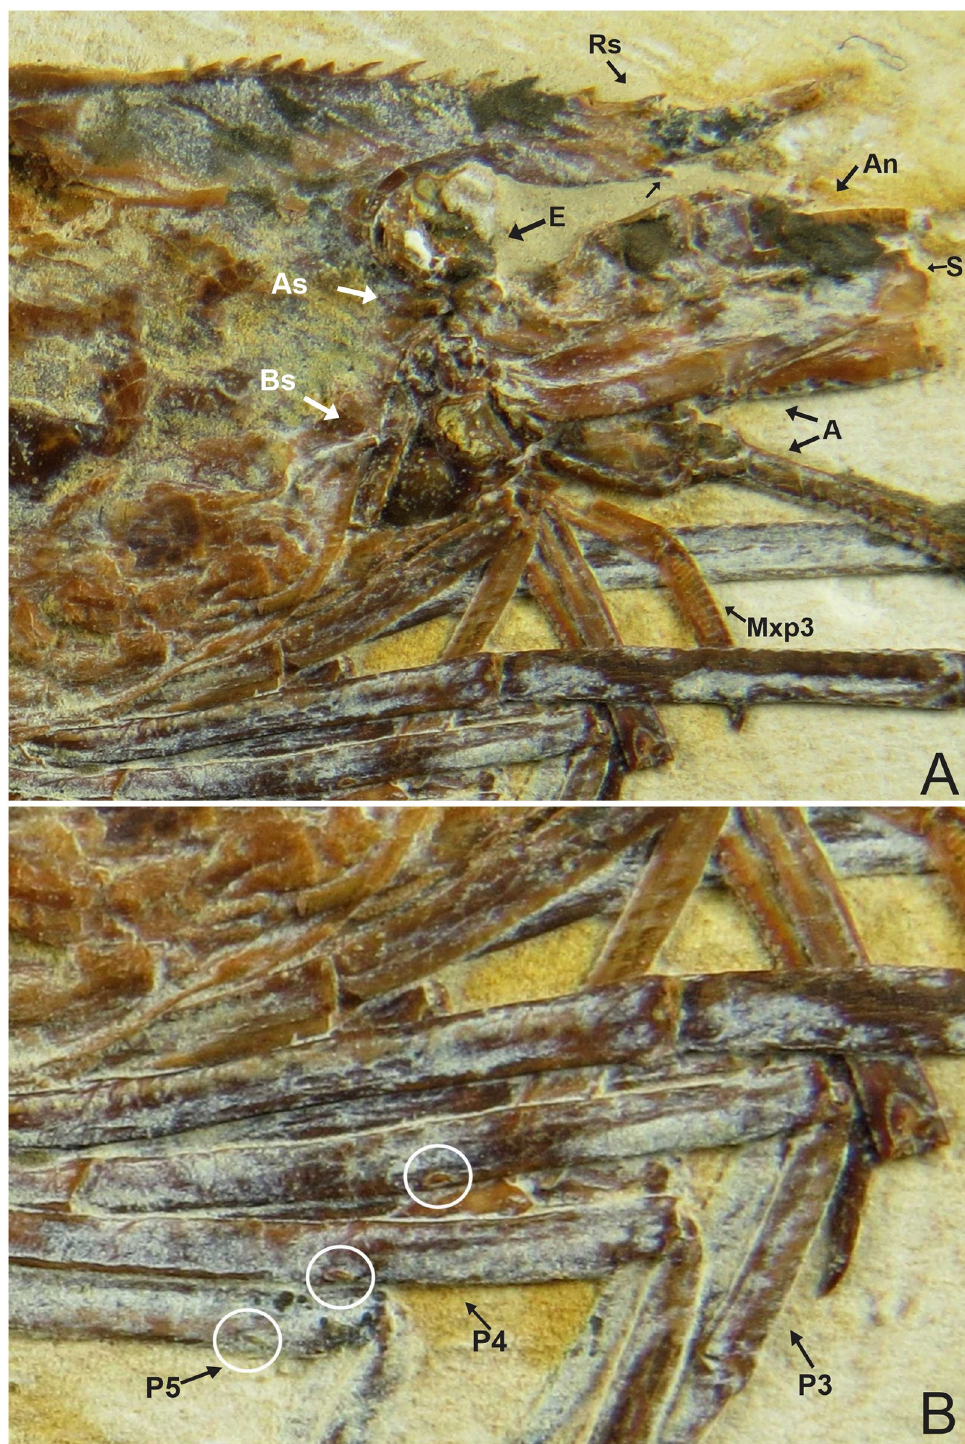
Fig 6. 1673/LPU. (A) The rostrum exhibits 12 supra-rostral spines with serrate appearance, two sub-rostral spines clear visible; brush’s presence of hairs (bristles) and spines well evident in the third maxilliped. (B) Detail of the Pereiopods P3-P5 have one spine in the merus. E: Eyes; Rs: Rostrum; An: Antennule; A: Antenna; S: Scaphocerite; As: Antennal spines; Bs: Branchiostegal spines; Mxp3: Third maxilliped. Photo by Olga A. Barros.